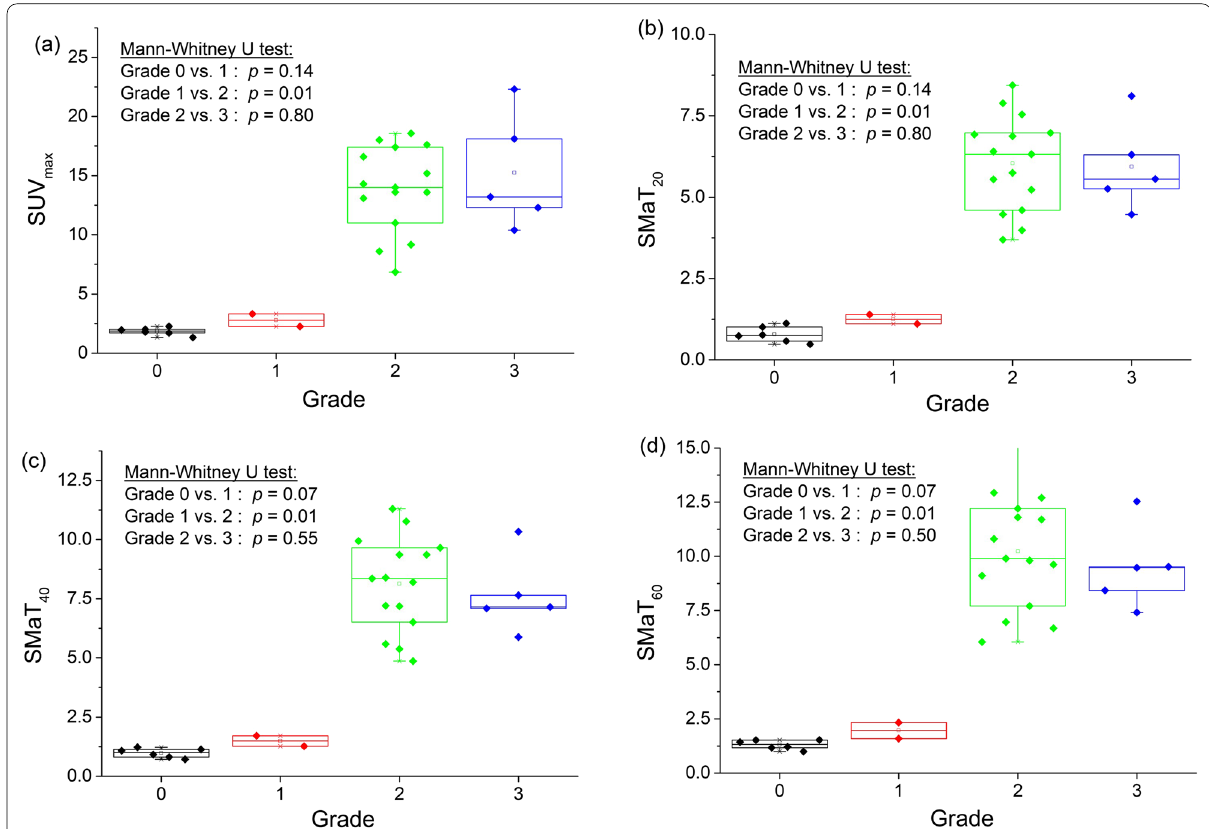
Fig. 2 Bar graph showing separation of quantitative myocardial activity a SUVmax, b SMaT 20 , c SMaT 40 , d SMaT 60 by visual cardiac uptake grade. SUV, standardized uptake value; SMaT 20 , SUV mean above 20% threshold; SMaT 40 , SUV mean above 40% threshold; SMaT 60 , SUV mean 60%